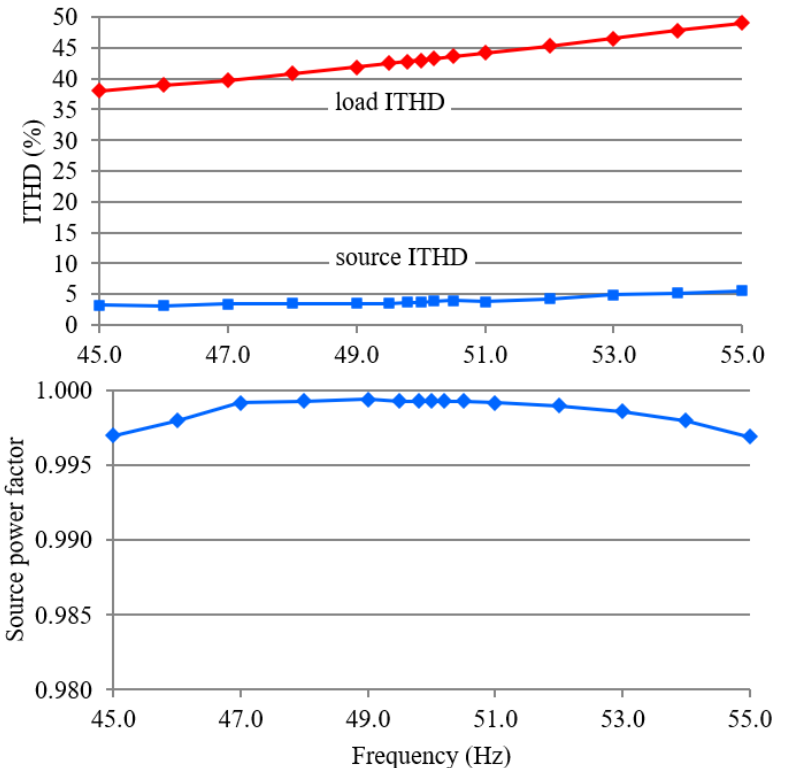
Figure 12. Performance of the UpfC control at different frequencies in a wide interval around the nominal 50 Hz value. Up: load and source ITHD . Down: source PF .